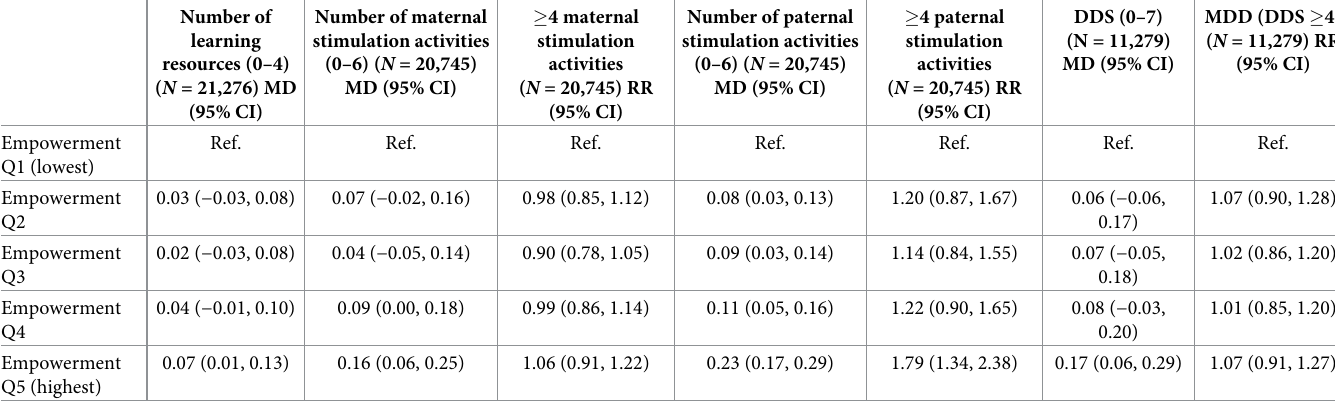
Table 4. Associations between quintile categories of women’s total empowerment and early learning and nutrition outcomes a